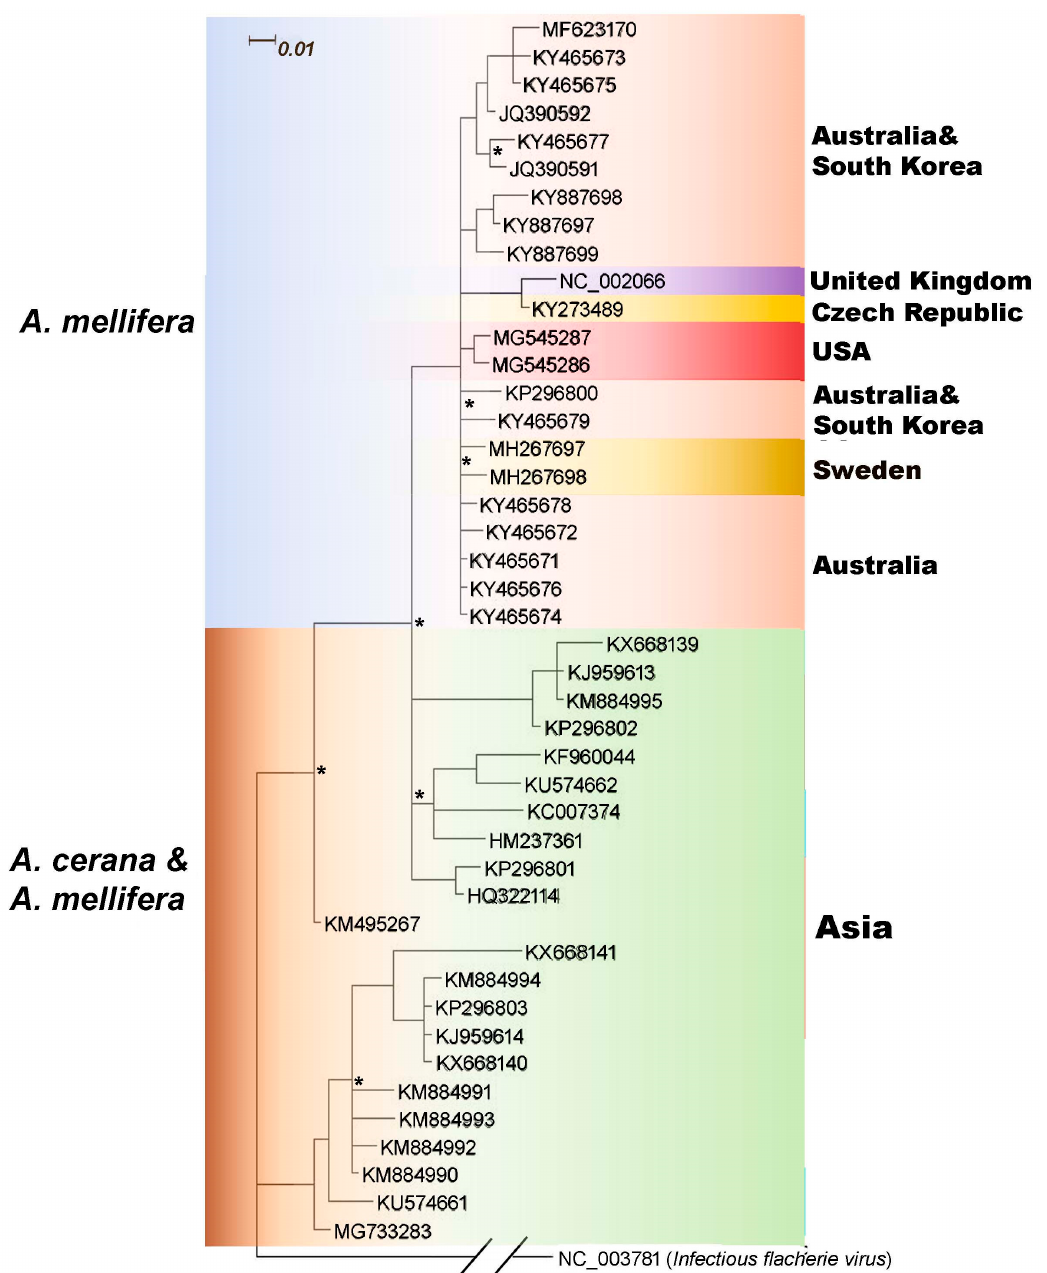
Figure 4. Phylogenetic tree of the 5 ′ untranslated region (5 ′ UTR) SBV sequences were retrieved from GenBank, and were trimmed to the 5’ UTRs. The phylogenetic tree was inferred by using MrBayes, and the analysis parameters were set to estimate relationships using the GTR model with gamma-distributed rate variation across sites and a proportion of invariable sites. Infectious flacherie virus (IFV, GenBank accession: NC_003781.1) was used as an outgroup to root the trees. Tree branches are colored by isolation host on the left, and country of isolation on the right. In some cases, isolates from multiple countries were intermingled, and are shown using the same color (e.g., Australia and South Korea). Nodes that are not supported with clade credibility values ≥ 90 are marked with *.